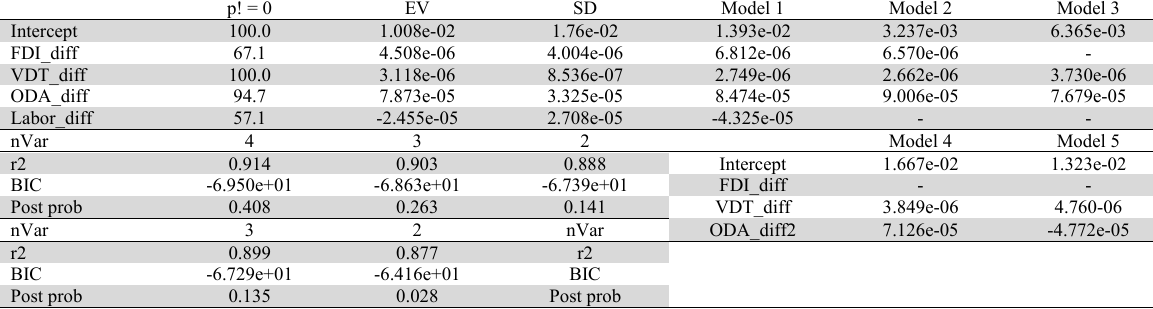
The optimal model selection from regression results